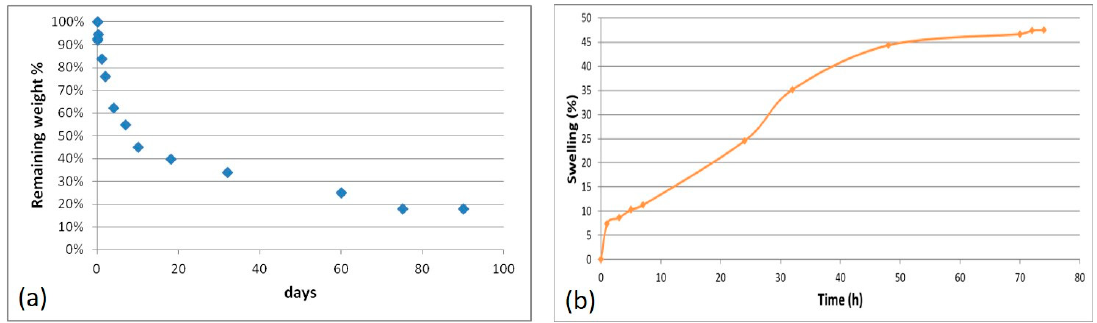
Figure 6. Results of the hydrolytic degradation test ( a ) and swelling test ( b ) performed on AGE sponges.